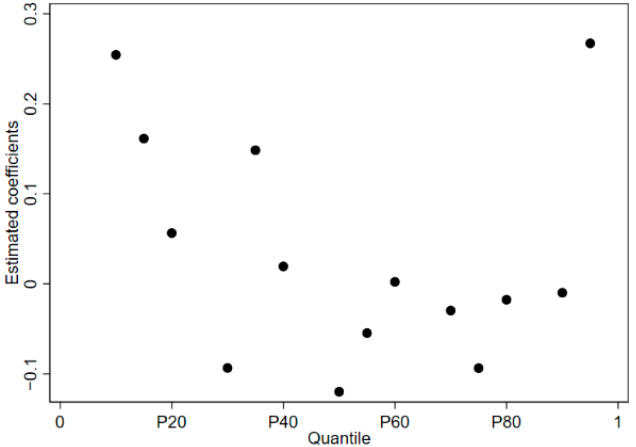
Figure 3. Estimated coefficients of different quantiles.